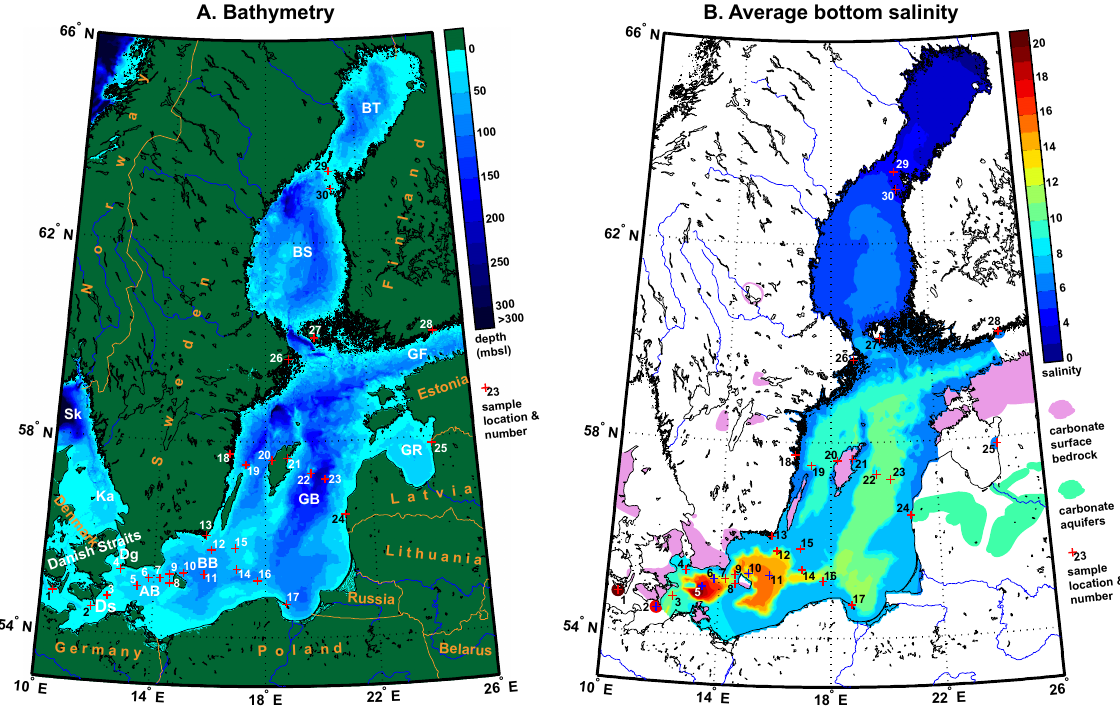
Fig. 1. (A) Baltic Sea bathymetry (IOC et al., 2003) with sample locations shown as crosses with associated sample location numbers in black text. Abbreviated white text denotes the following: Sk=Skagerrak, Ka=Kattegat, Dg=Drogden Sill, Ds=Darss Sill, AB=Arkona Basin, BB=Bornhom Basin, GB=Gotland Basin, GR=Gulf of Riga, GF=Gulf of Finland, BS=Bothnian Sea, and BT=Bothnian Bay. (B) Average bottom salinity map for the Baltic Sea, salinity map is for the period 1900–1940AD from HELCOM (2013). Salinity data for locations 1, 2, 25 and 28 is for the period 1900–1996AD and from Janssen et al. (1999). Also shown are land areas with carbonate bedrock and aquifers (pink and light green areas, respectively, following Stephens et al., 1994; Kalberg et al., 2007; BGR Hannover et al.,